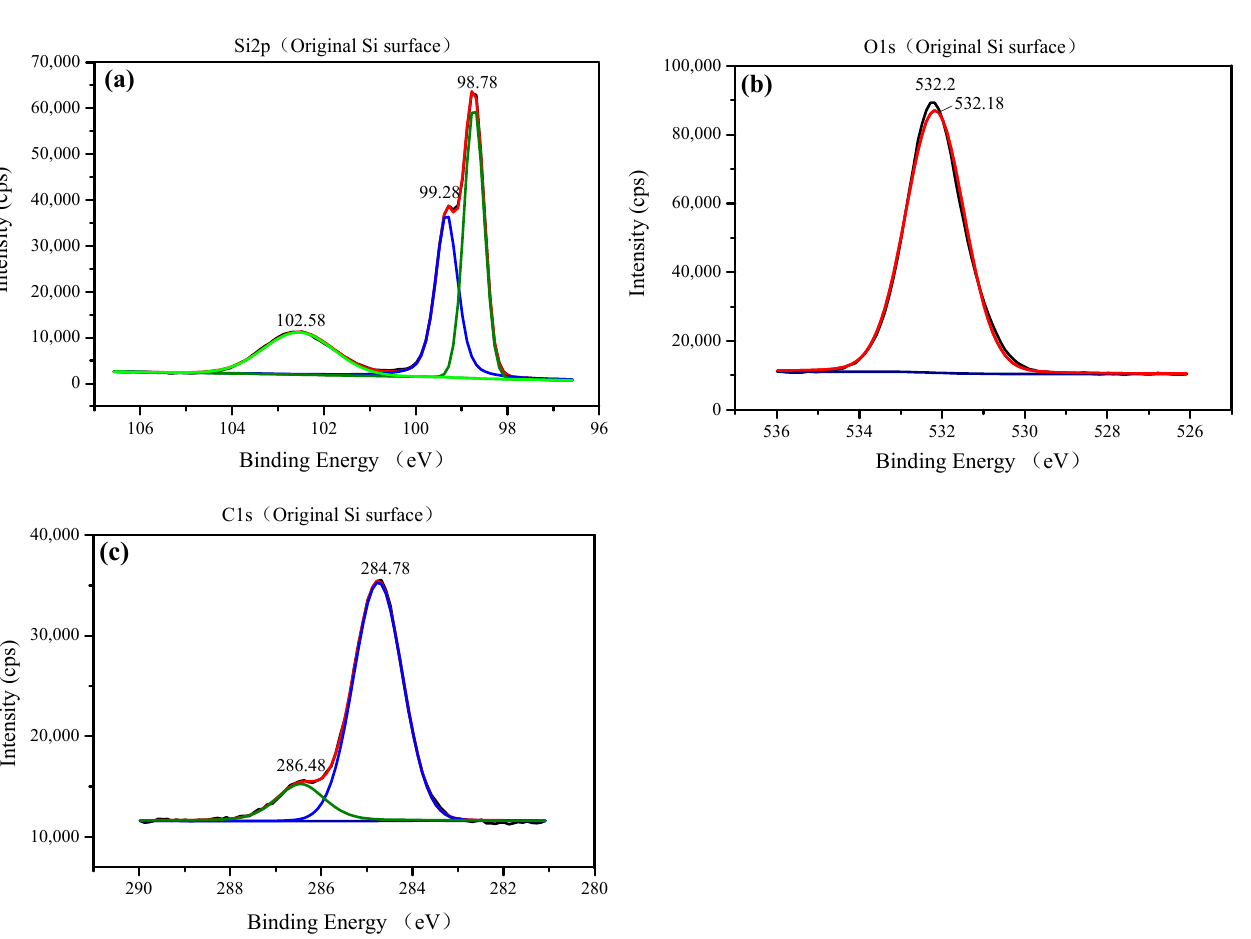
Figure 11. XPS spectra of the original Si surface: ( a ) Si2p, ( b ) O1s, and ( c ) C1s.